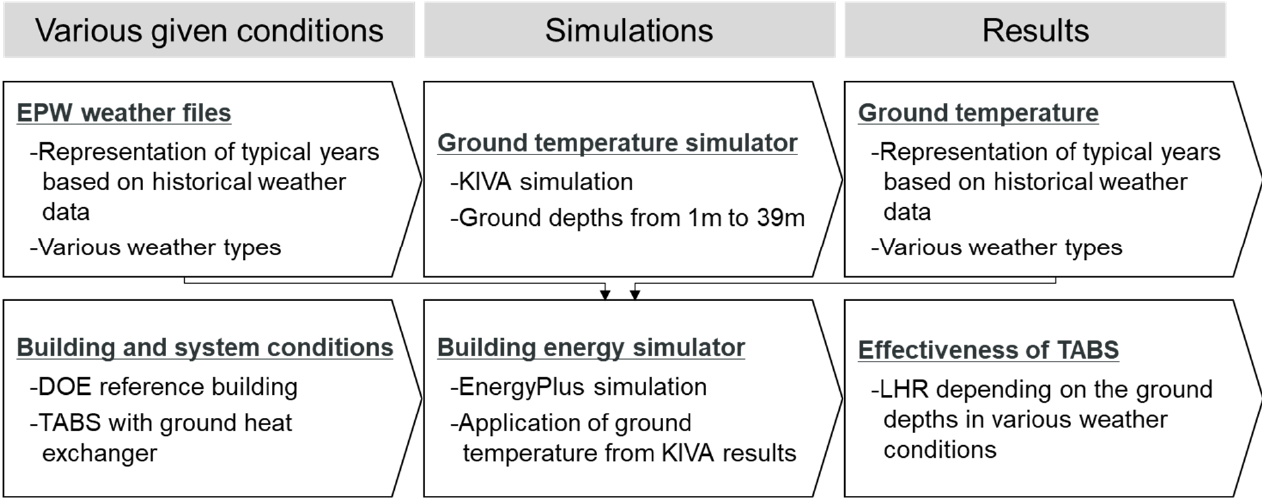
Figure 1. Flow chart of the study on evaluation of TABS integrated with ground exchanger.